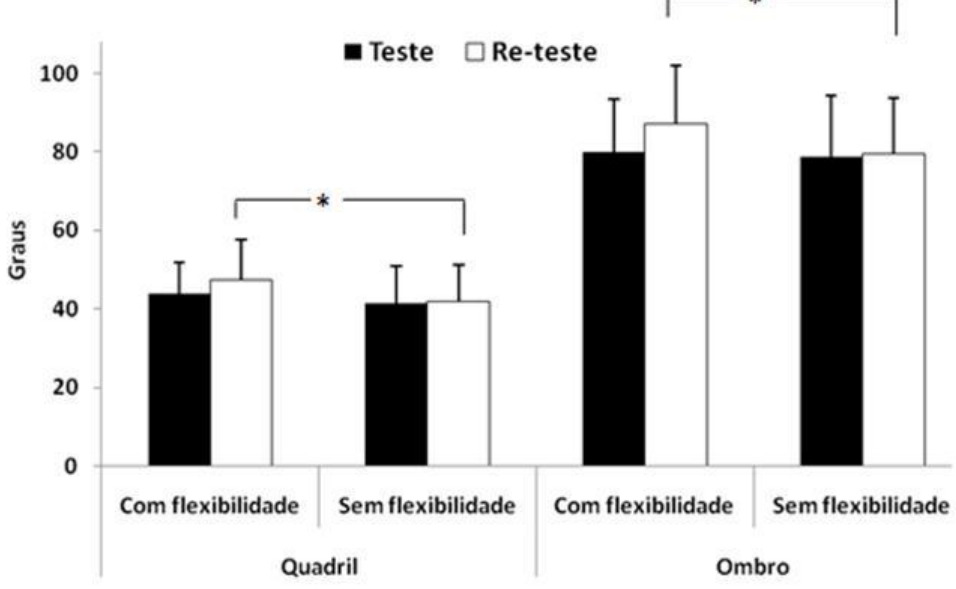
Figura 2. Valores médios (  desvio padrão) de ângulo articular de extensão do quadril e de abdução de ombro nas condições com e sem os exercícios de flexibilidade. *valor com flexibilidade maior que sem flexibilidade intra-articulação